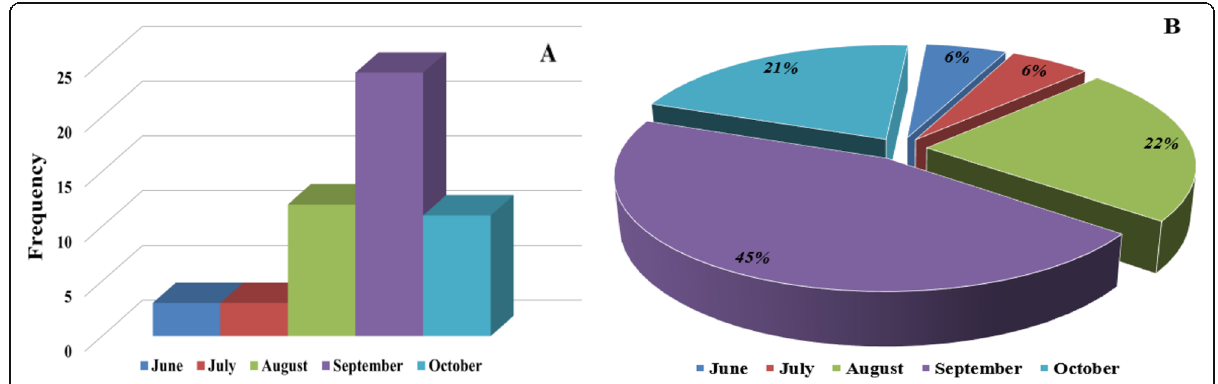
Fig. 7 Monthly frequency ( A ) and percentage ( B ) of landslides between 1954 and